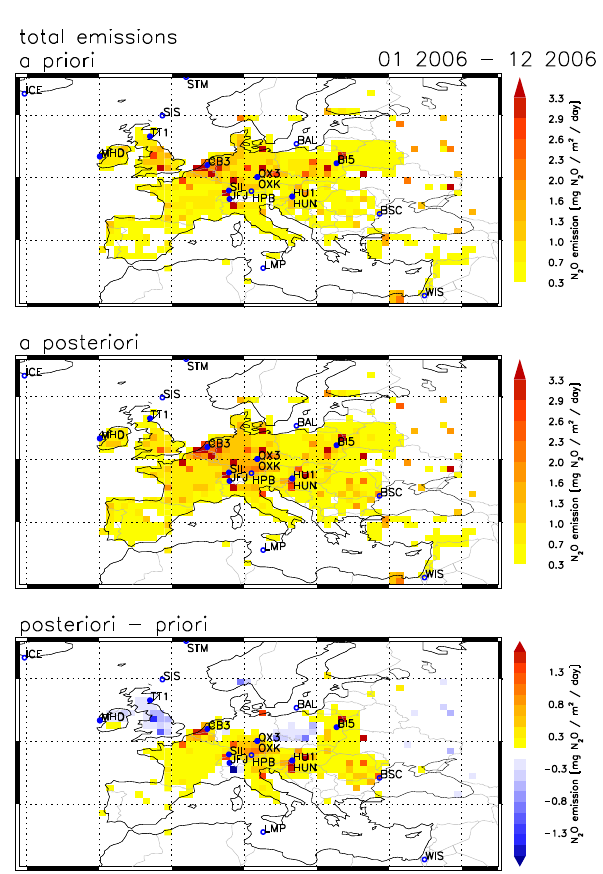
Fig. 3. A priori (top panel) and a posteriori (mid panel) emissions over the European domain (annual mean emissions for 2006). Bot- tom panel represents the difference between the two fields (a pos- teriori - a priori). Filled circles represent stations which take con- tinuous measurements, open circles sites those with flask measure- ments.